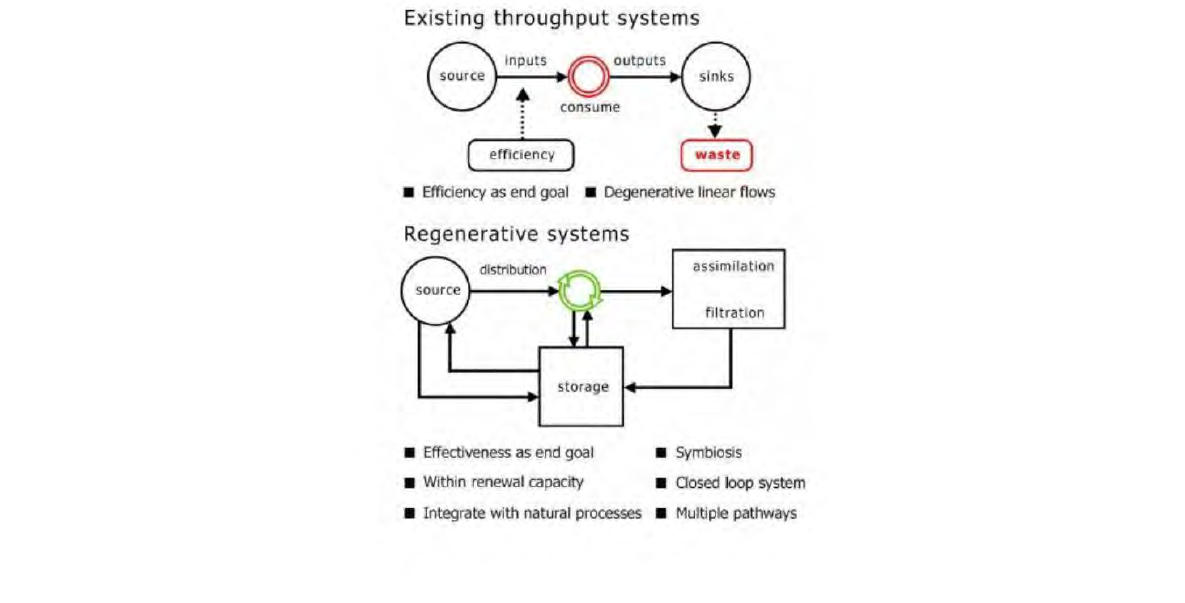
Figure 1. Lyle’s comparison between flows in degenerativeand regenerative systems (Hes & Plessis, 2015). Regenerative design or development does not only refer to reviving a system, or restoring it to a better state, but to